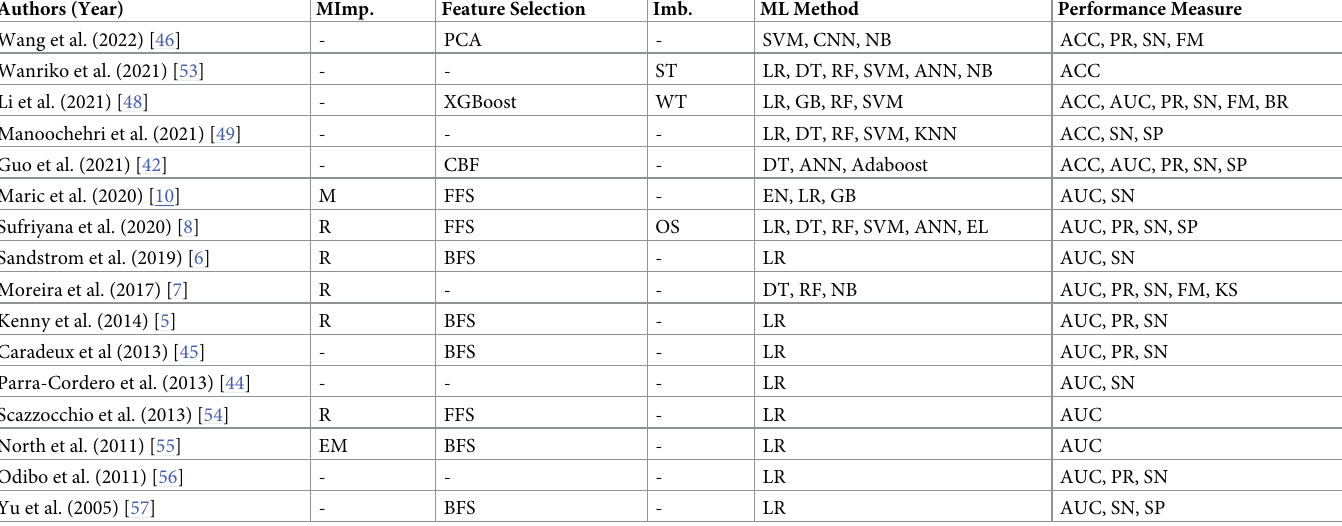
Table 1. Summary of early-onset PE prediction previous studies with methods they used. MImp.: Missing imputation technique, R: Removal technique, EM: Expected maximization, M: Mean Imputation, FFS: Forward Feature Selection, BFS: Backward Feature Selection, CBF: Correlation Based Feature Selection, PCA: Principal Compo- nant Analysis, Imb.: class imbalance method, OS: oversampling, WT: class-weight adjustment, ST: SMOTE, LR: Logistic regression, EN: Elastic Net, DT: Decision Tree, RF: Random Forest, SVM: Support vector machine, ANN: Artificial Neural Network, GB: Gradient Boosting, EL: Ensemble Learning, NB: Na ï ve Bayes, KNN: K Nearest Neighbor, KS: Kappa statistics, SN: Sensitivity, SP: Specificity, ACC: Accuracy, PR: Precision, GM: G-mean, FM: F-measure, BR: Brier Score. Authors (Year)